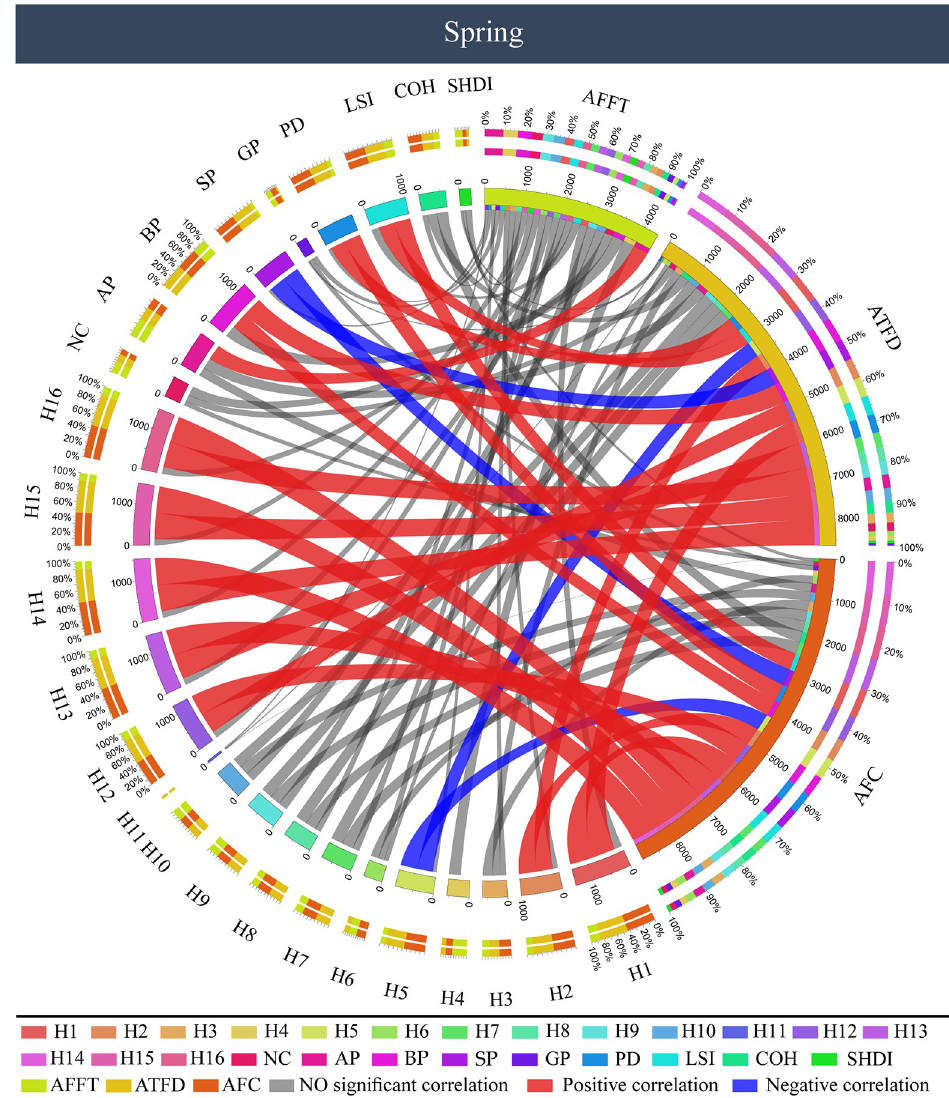
Fig 6. Correlation between color characteristics and visual behavior of forest color photos in spring. AFFT: AOI first fixation time, ATFD: AOI total fixation duration, AFC: AOI fixation count. time (AFFT) was significantly positively correlated with the proportion of coniferous forest color patches (AP) (P < 0.05); there was no significant correlation with forest color compo- nents and other forest color patches (P > 0.05). The correlation results between the AOI total fixation duration (ATFD) and forest color characteristic indexes were consistent with those between the AOI fixation count (AFC) and forest color characteristic indexes. Among the for- est color components, AOI total fixation duration (ATFD) and AOI fixation count (AFC) were positively correlated with red (H1, H2) and blue-violet (H12–16), and negatively corre- lated with green (H5) (P < 0.05). Among the spatial components of forest color patches, the two are significantly positively correlated with the proportion of broad-leaved forest color patches (BP), color patch density (PD), and color landscape shape index (LSI), and negatively correlated with the proportion of shrubwood (SP) (P < 0.05).